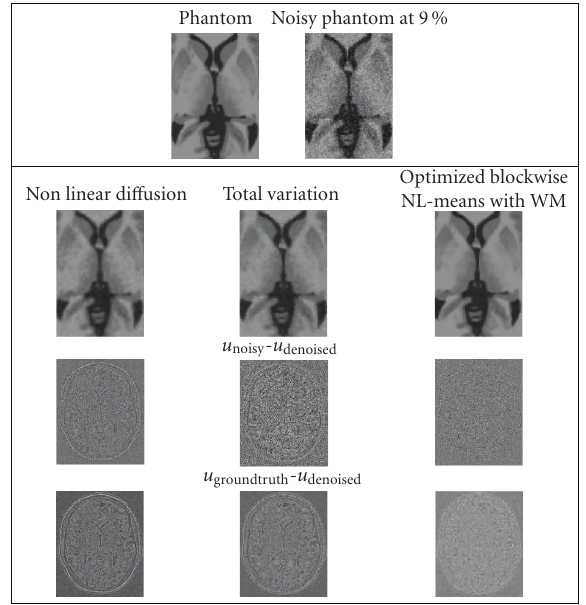
Figure 10: Comparison between nonlinear di ff usion, total variation, and our optimized blockwise NL-means with wavelet mixing denois- ing on synthetic T1-w images. Top. Zooms on T1-w BrainWeb im- ages. Left. The “ground truth”. Right. The noisy images with 9% of Gaussian noise. Middle. The results of restoration obtained with the di ff erent methods and the images of the removed noise (i.e., the di ff erence (centered on 128) between the noisy image and the de- noised image. Bottom. The di ff erence (centered on 128) between the denoised image and the ground truth. Left. Nonlinear di ff usion denoising. Left. Nonlinear di ff usion denoising. Middle. Total vari- ation minimization process. Right. Optimized Blockwise NL-means with WM filter. The NL-means-based restoration better preserves the anatomical structure in the image while e ffi ciently removing the noise as it can be seen in the image of removed